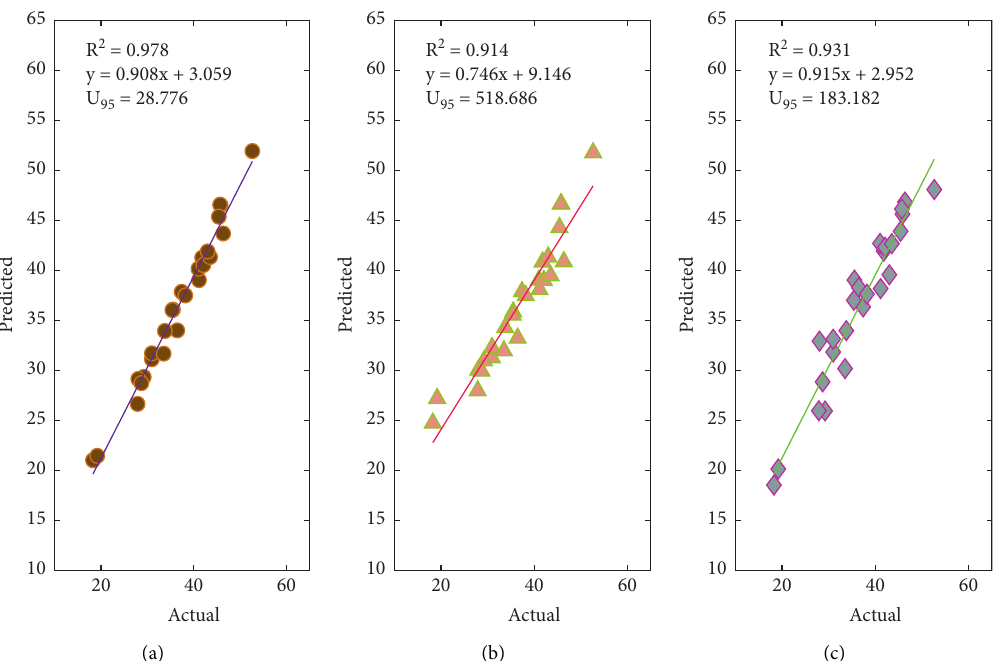
Figure 5: Comparing between actual and predictive values: correlation of determination, (a, b, and c) respectively belong to SVR-PSO, ELM, and